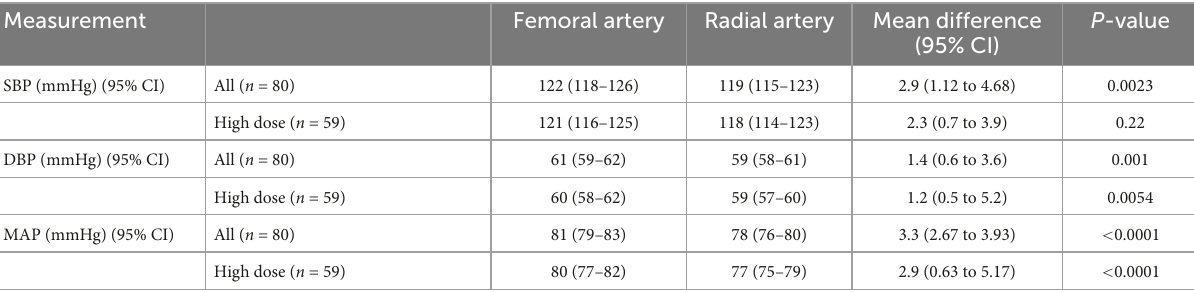
TABLE 2 Systolic blood pressure (SBP), diastolic blood pressure (DBP) and mean arterial pressure (MAP) at femoral and radial arterial sites in study patient cohort. Measurement Femoral artery Radial artery